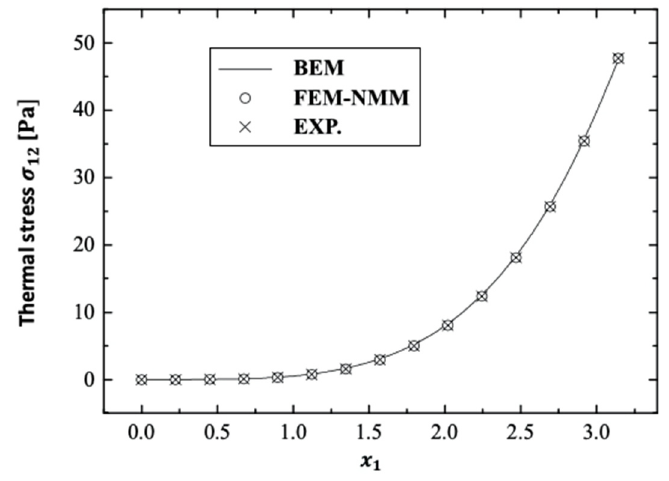
Figure 15. Distribution of the thermal stress wave σ 12 along x 1 –axis in the special case of anisotropic FRP composites for BEM, FEM-NMM, and Exp.